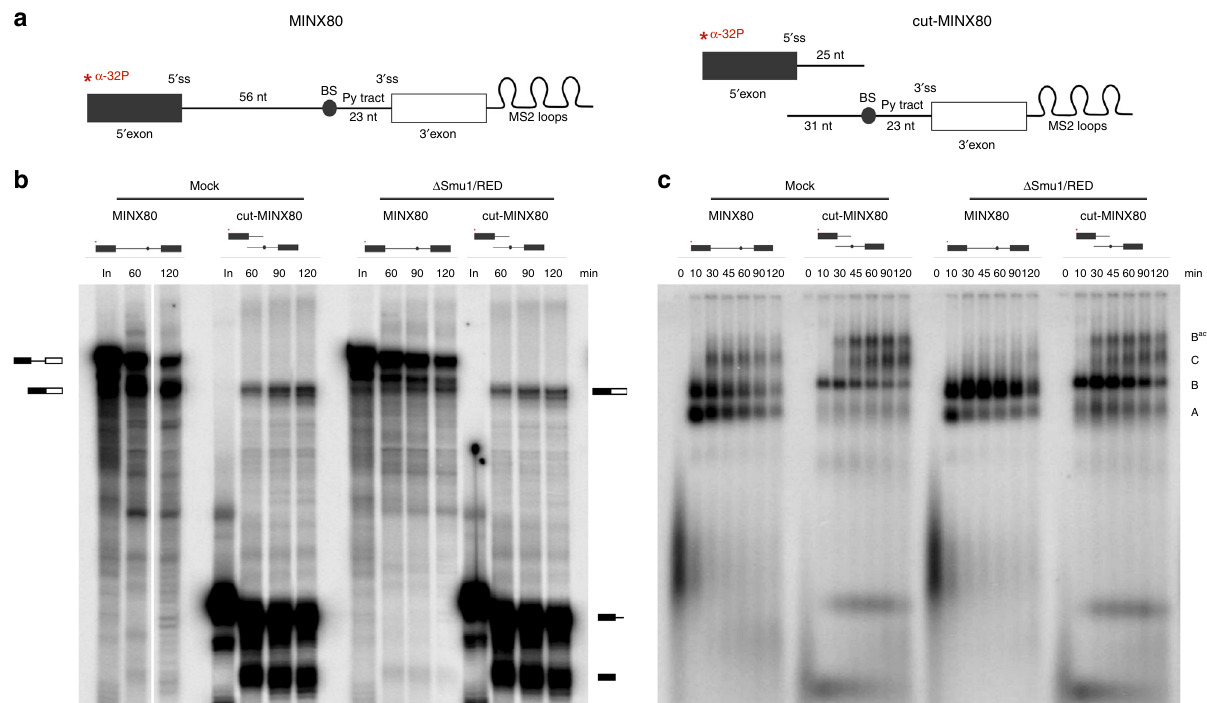
Fig. 6 Cleavage of the MINX80 intron restores spliceosome activation in Δ Smu1/RED nuclear extract. a Schematic of the MINX80 and cut-MINX80 pre- mRNAs. Cut-MINX80 was generated by transcribing the MINX80 pre-mRNA in two parts, where only the 5 ′ half was 32 P-radiolabelled (indicated in red). b , c Kinetics of in vitro splicing ( b ) and spliceosome assembly ( c ) of the MINX80 and cut-MINX80 pre-mRNAs in mock- and Smu1/RED-depleted extract. The pre-mRNA and splicing intermediates/products, as well as spliceosomal complex formation, were analysed as in Fig. 2. Source data are provided as a Source Data fi